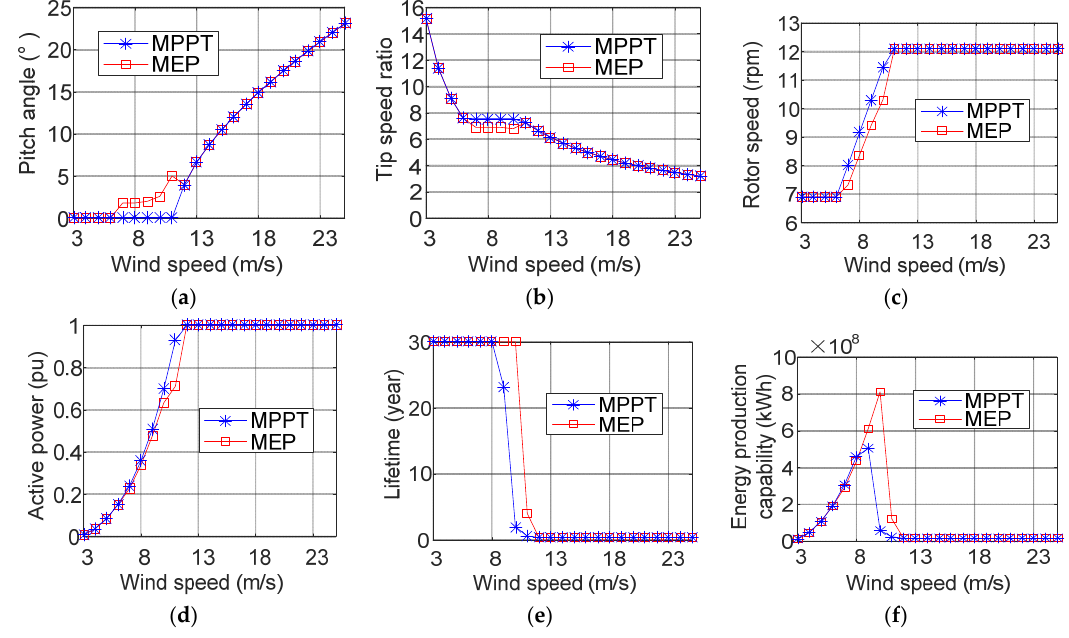
Figure 18. At the wind direction of 270°, comparison between the MPPT method and the proposed MEP method of: ( a ) pitch angle; ( b ) tip speed ratio; ( c ) rotor speed; ( d ) active power; ( e ) lifetime; ( f ) energy production capability of WT1.